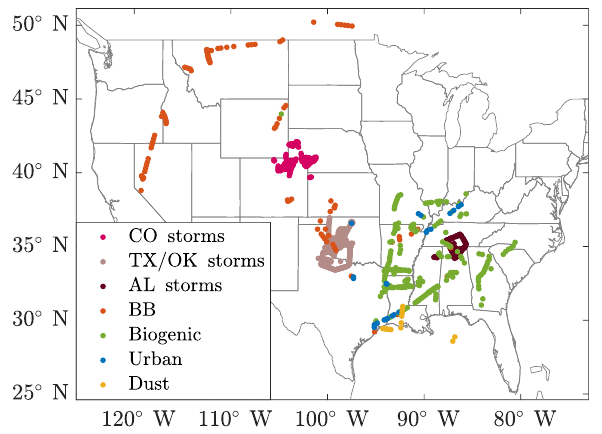
Figure 2. The results of the air mass classification scheme as a func- tion of geographic location.